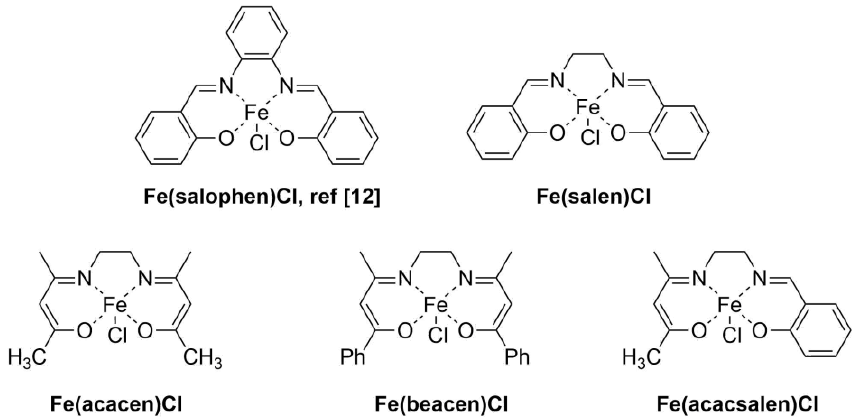
Figure 1. Iron complexes with tetradentate N 2 O 2 ligands employed in this work. H 2 salophen: N,N’-